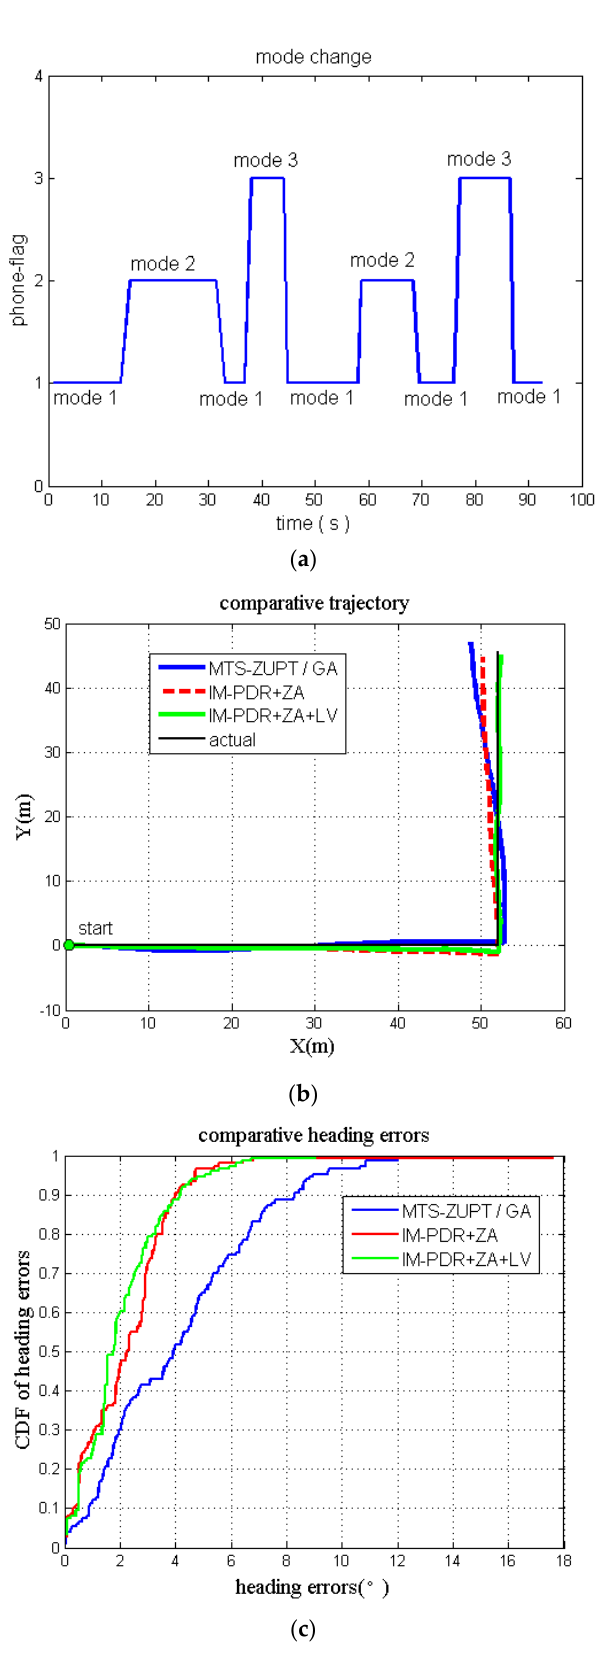
Figure 11. Results of L-shape taste: ( a ) mode change results; ( b ) comparative trajectories; ( c ) comparative heading errors.